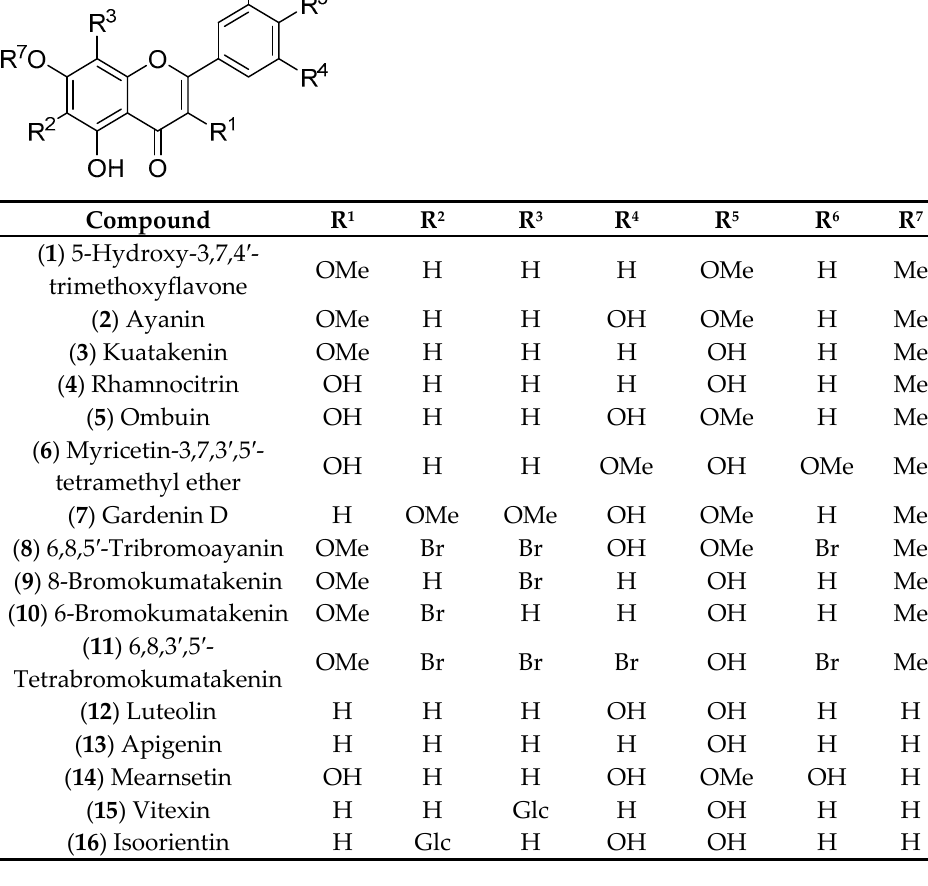
Figure 1. Chemical structures of 1 – 16 . Compounds 2 and 3 were selected for bromination to obtain new flavones (Scheme 1). The reactions were conducted using hydrogen peroxide and potassium bromide in acetic acid (Scheme 1). As a result, compound 8 was prepared from 2 while products 9 – 11 were derived from 3 . The isolated yields of these compounds were 35–93%. The 1 H NMR spectrum of 8 displayed two meta-coupled protons at δ H 7.88 and 8.18, three methoxy groups at δ H 3.80 and 3.97 (x2), and one hydrogen-bond hydroxyl group at δ H 15.71. NMR data of 8 and its mother compound 2 was highly similar. The differences are the disap- pearance of three aromatic protons (H-6, H-8, and H-5 ′ ), indicating that three positions were brominated. Altogether, the chemical structure of 8 was elucidated as shown. The identification of compounds 9 – 11 was readily established on the basis of their 1 H, 13 C NMR, and HRESI mass spectra (Tables S3 and S4).